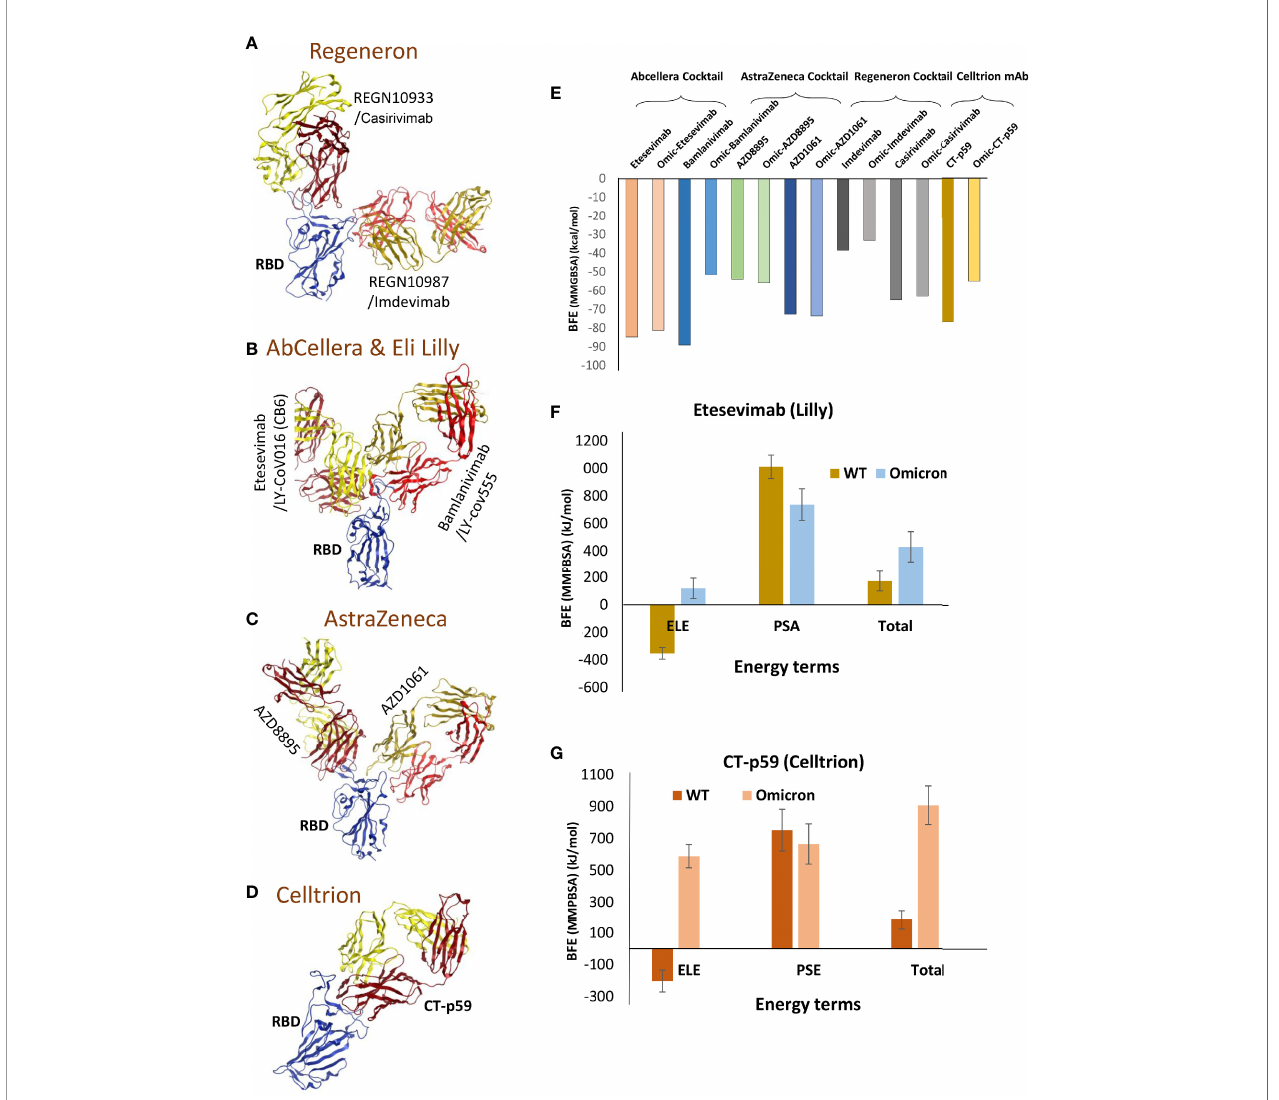
FIGURE 3 | Mutations in the Omicron RBD distort the epitopes of therapeutic mAbs. (A – D) Crude epitopes of seven selected mAbs are shown on the RBD. Antibodies used as cocktails are labeled with their sponsors. All variable light chains are colored yellow or orange and variable heavy chains are colored red. (E) Changes in the binding af fi nity of the RBD Omic – mAbs relative to RBD WT – mAbs are shown. The binding energies were calculated through endpoint MMGBSA. (F) The binding free energies (measured through MMPBSA) as consequences of all 15 mutations at once were monitored for RBD Omic – etesevimab and RBD WT – etesevimab. (G) The binding free energies (measured through MMPBSA) as consequences of all 15 mutations at once were monitored for RBD Omic – CT-p59 and RBD WT –